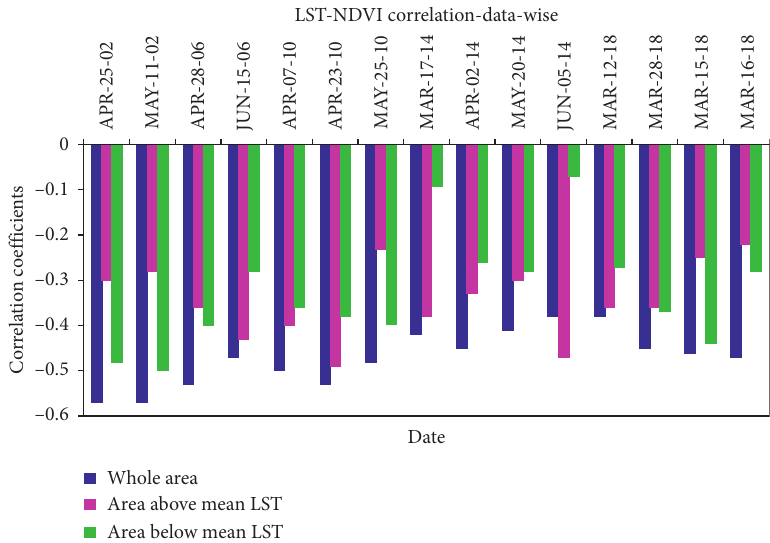
Figure 11: Date-wise LST-NDVI correlation analysis.